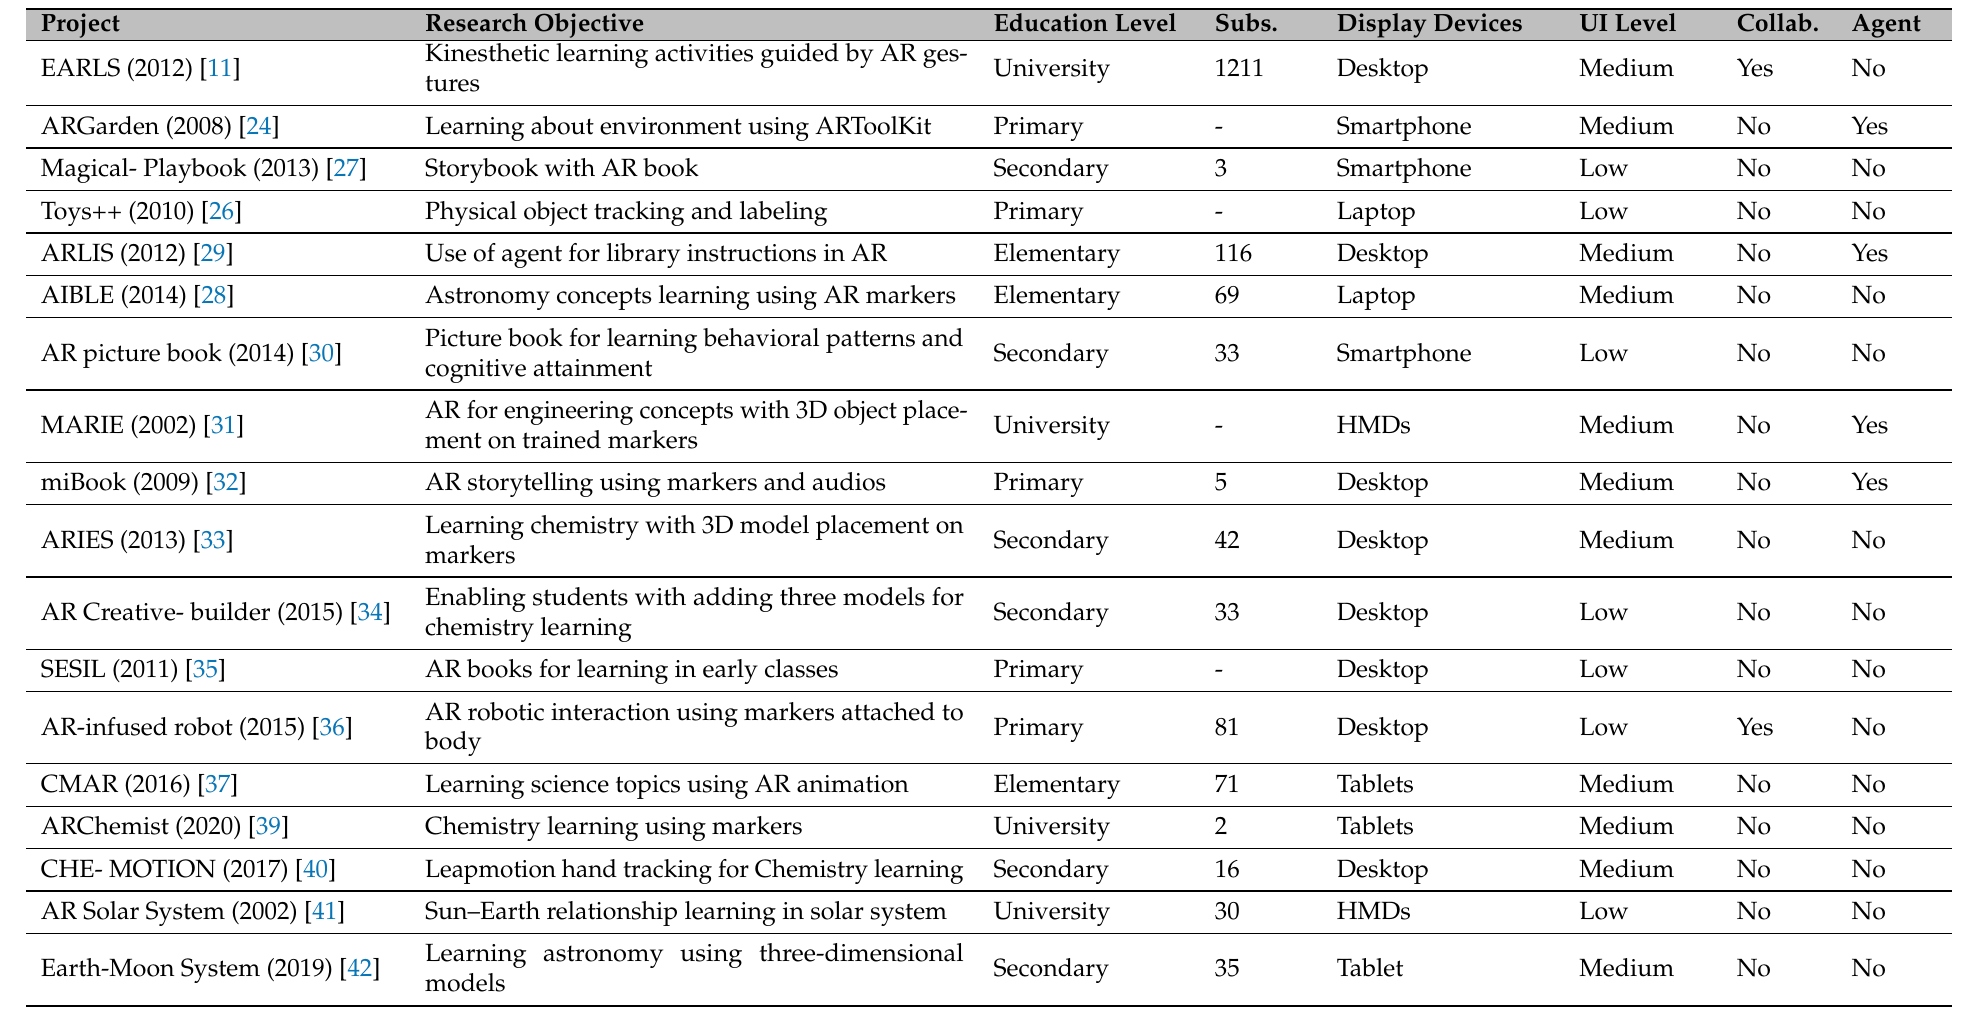
Table 1. AR studies with their status of domain, education level, libraries, display devices, user interaction, collaboration capacity and